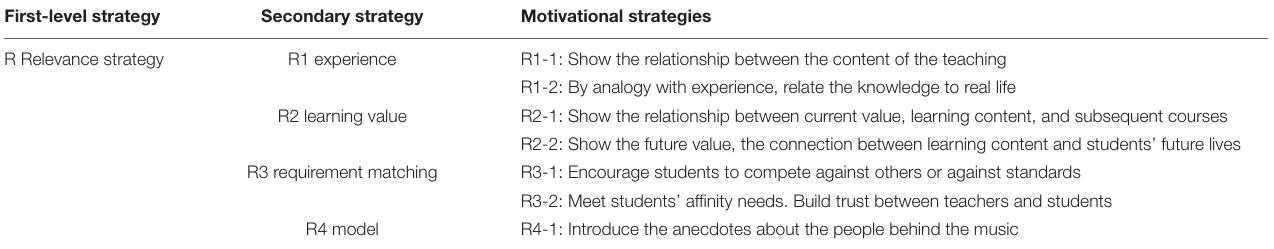
TABLE 2 | Relevance strategy coding system after optimization.